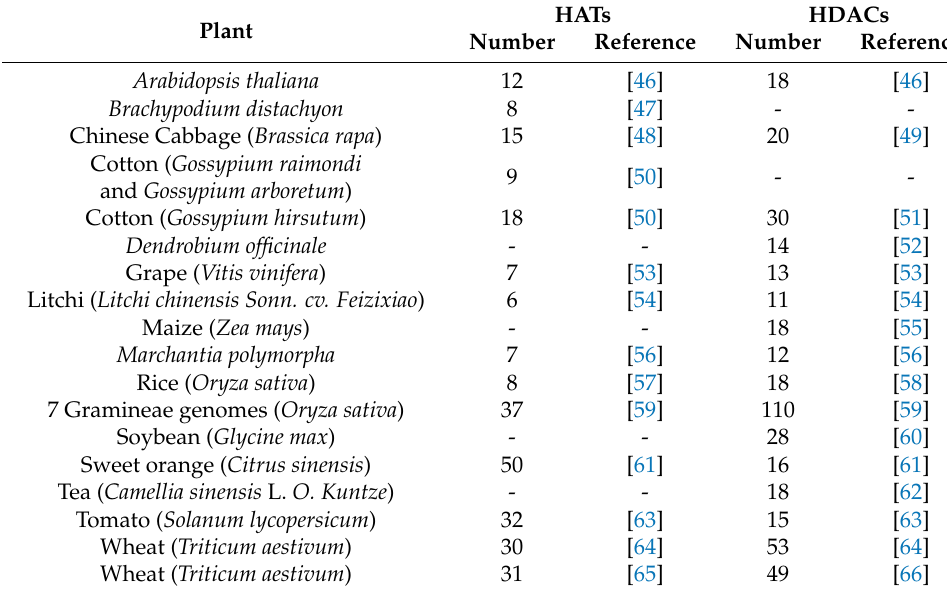
Table 1. Identification of HATs and HDACs in different